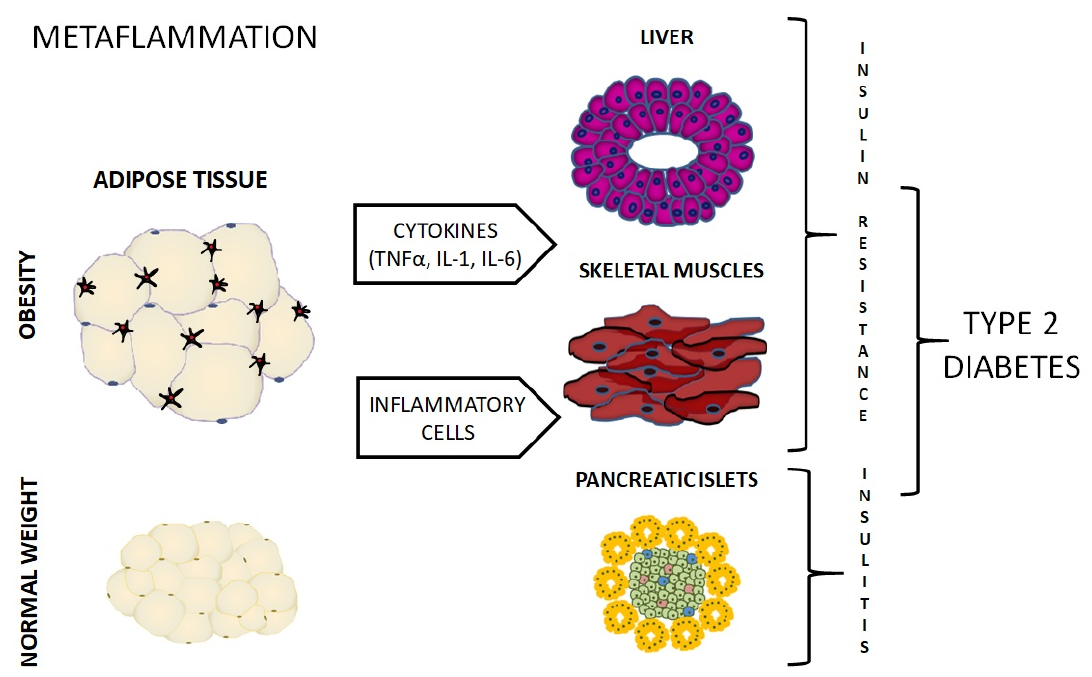
Figure 1. A schematic presentation of the concept of metaflammation.